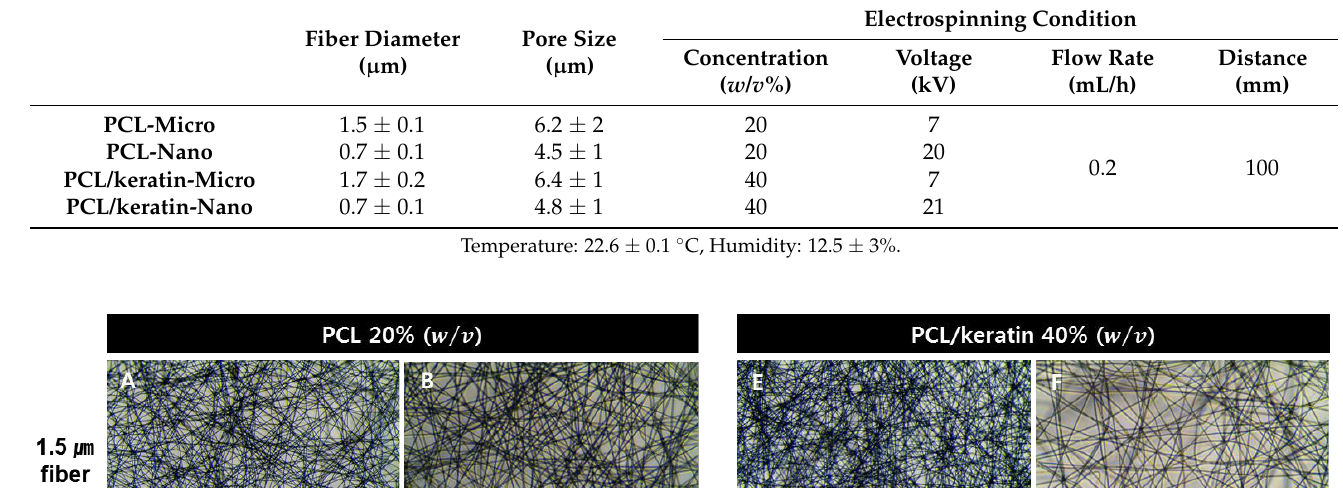
Table 1. Fiber diameters and pore sizes of 20% ( w / v ) PCL and 40% ( w / v ) PCL/keratin with respect to the electrospinning process parameters.